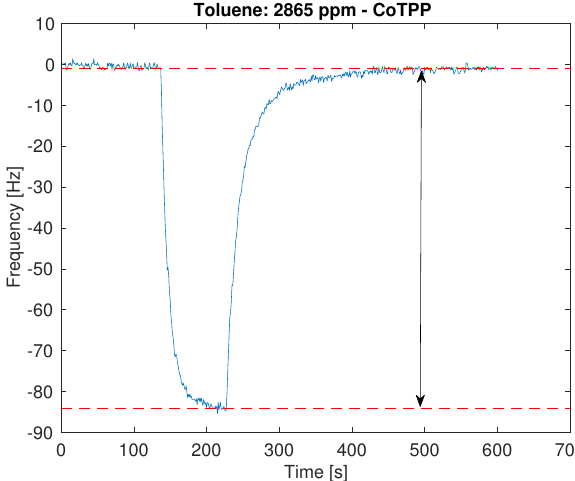
Figure 1. Time progression of the frequency shift of the sensor functionalized with CoTPP. The sensor is constantly kept in a nitrogen flow, from t = 130 s to t = 230 s 2865 ppm of toluene are added to nitrogen flow. After removal of the toluene, the sensor signal recovers the baseline. The line with two arrows indicates the sensor response used in the successive